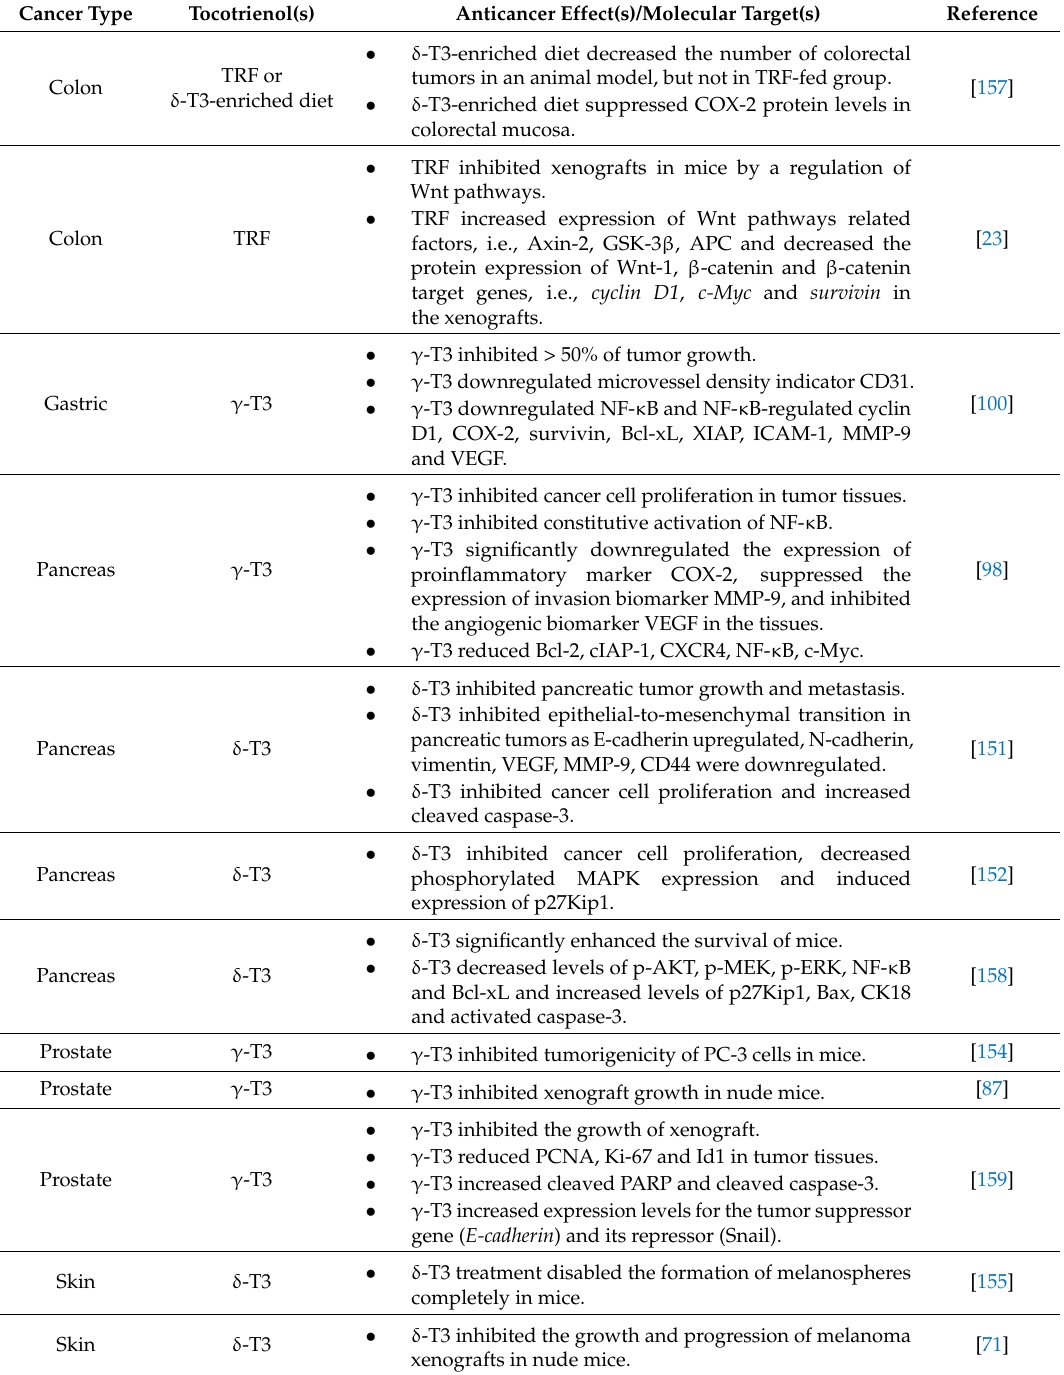
Table 2. Exemplar in vivo studies of tocotrienols for various cancer treatments using mouse models. Cancer